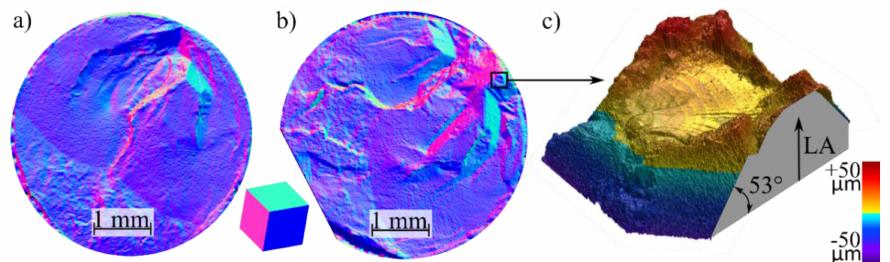
Figure 7. Fracture surface observations using CLSM of the EBM material. ( a ) Normal map of a sample deformed at σ a = 158 MPa (N f = 6.5 × 10 6 ). ( b ) Normal map of a sample deformed at σ a = 149 MPa (N f = 4.5 × 10 7 ). ( c ) Detailed CLSM scan of the sample shown in ( b ) including the direction of the load axis (LA) and the angle between the facet normal plane and the plane normal to the load axis.